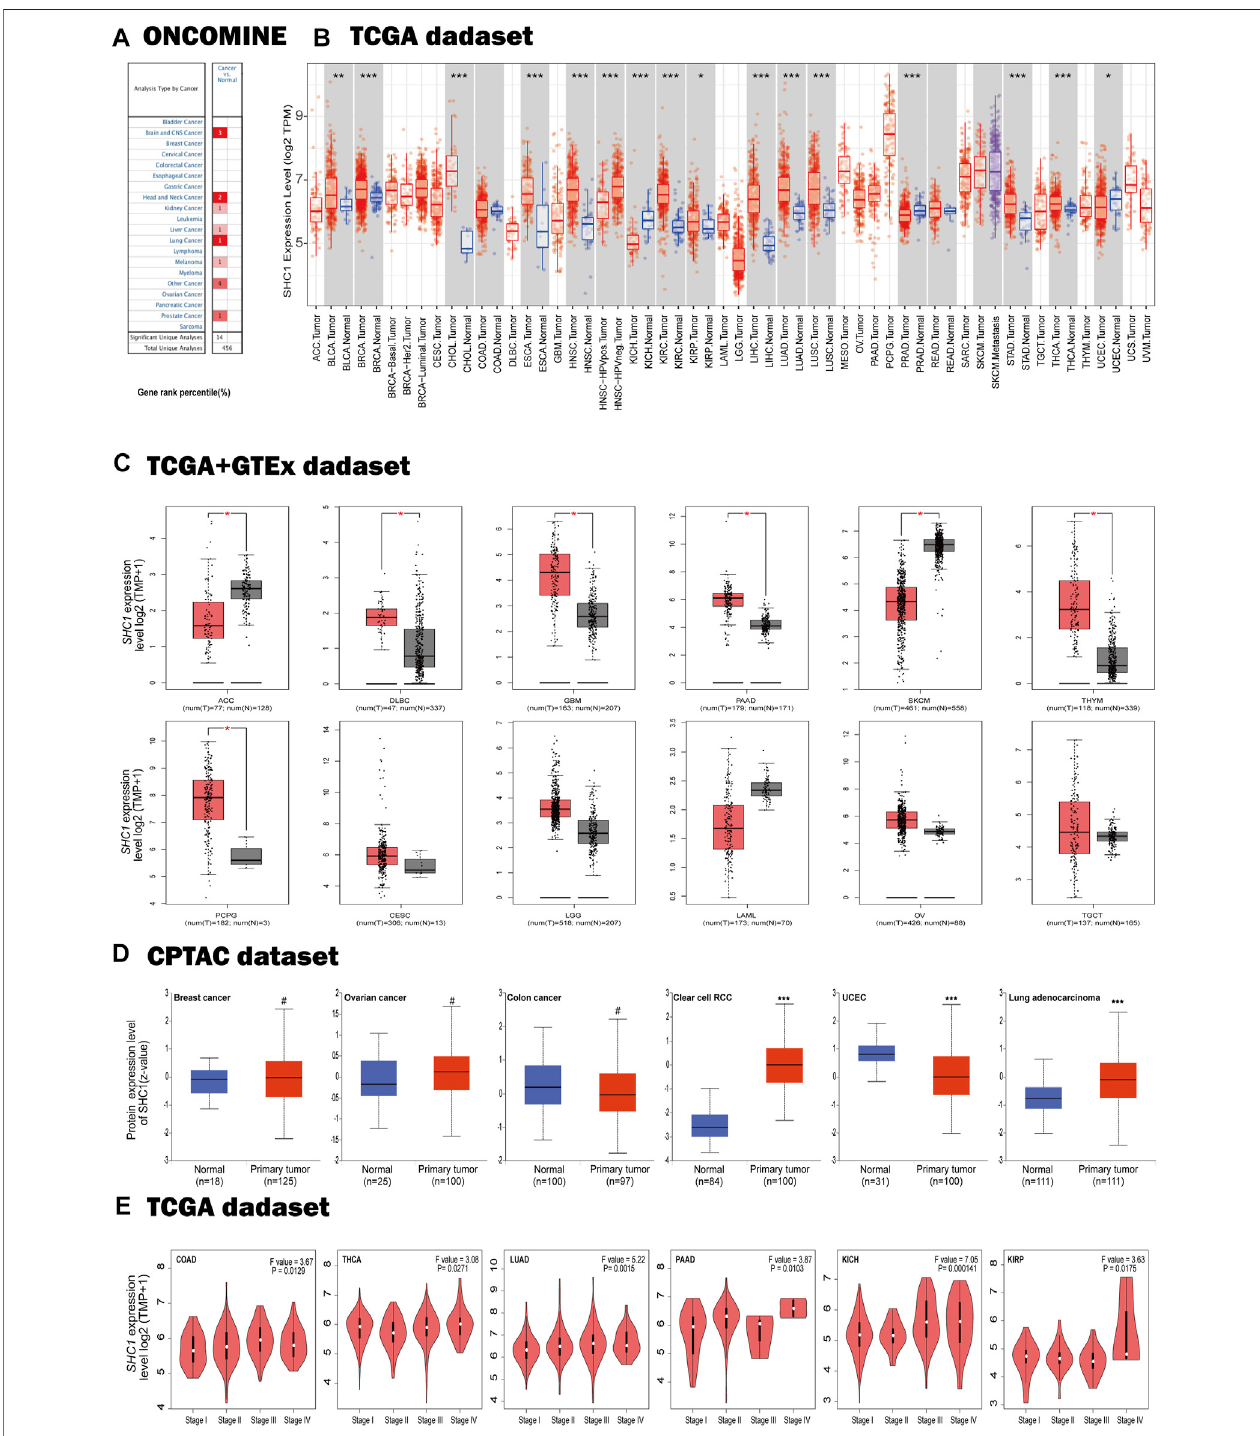
FIGURE1 | Expression pro fi les of SHC1 in tumors at differentpathological stages. (A) Increased SHC1 expression ofdifferent cancersversus normal tissues from the Oncomine database. (B) The mRNA expression pro fi les of SHC1 in different cancers determined using TIMER2.0 (* p < 0.05; ** p < 0.01; *** p < 0.001). (C) ACC, DLBC, GBM, PAAD, SKCM, THYM, CESC, LGG, LAML, OV, SARC, and TGCT in the TCGA database and the controls from the GTEx database. Data were expressed as box plots. (* p < 0.01) (D) Boxplot results of the expression levels of SHC1 in breast cancer, ovarian cancer, colon cancer, clear cell RCC and UCEC analyzed using the CPTAC dataset. ( # p > 0.05, *** p < 0.001). (E) The mRNA values of SHC1 of COAD, THCA, LUAD, PAAD, KICH, and KIRP evaluated at the main pathological stages (stage I, stage II, stage III, and stage IV) using the GEPIA2. Log2 (TPM+1) was used for log-scale.